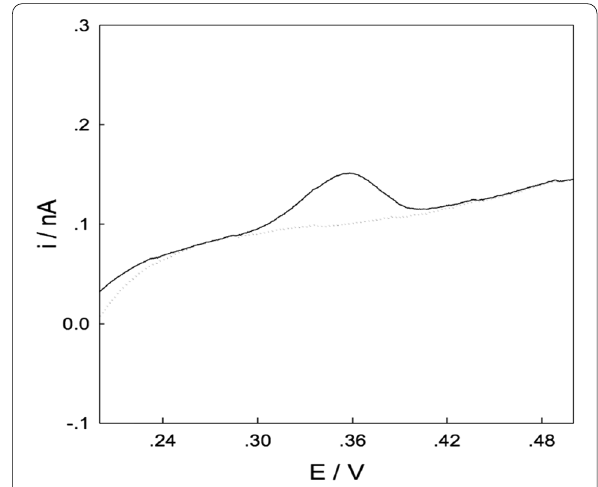
Fig. 8 Anodic peak of the voltammetric curve of the gold microelectrode in electrode without Cu(II) (dashed line) and the linear sweeping voltammetry curve in HNO_3 (0.01 M) solution having 1 μm of Cu(II) at fifty mV/s scan rate (solid line) (Zhuang et al.